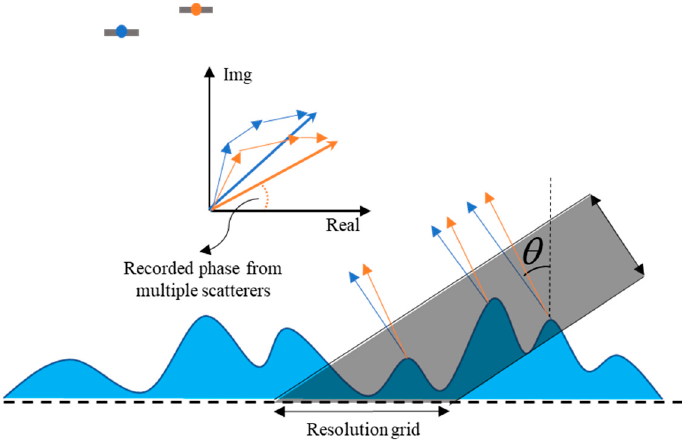
Figure 12. Schematic diagram of wave volume decorrelation.